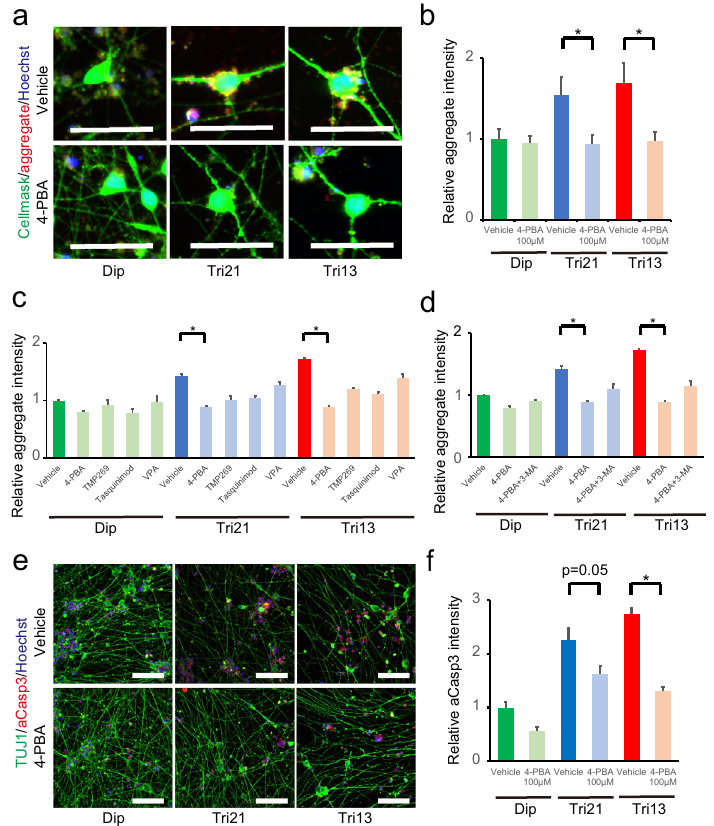
Figure 6. 4-PBA ameliorated aggregation and neuronal loss in trisomic neurons. ( a ) Representative images showing immunocytochemical staining for aggregates (red) in diploid and trisomic NGN2-neurons treated with vehicle or 4-PBA. CellMask (green) and Hoechst 33342 (blue), counterstaining. Scale bar = 50 μm. ( b ) Quantification of relative aggregate intensity per cell in NGN2-neurons on day 14. Data are presented as mean ± SEM normalized to the average of diploid clones. * P < 0.05, n = 5–7 per clone. ( c ) Quantification of relative aggregate intensity per cell in diploid and trisomic NGN2-neurons treated with vehicle or HDAC inhibitors on day 14. Data are presented as the mean ± SEM normalised to the average of diploid clones treated with vehicle. * P < 0.05, n = 3–6 per clone. ( d ) Quantification of relative aggregate intensity per cell in diploid and trisomic NGN2-neurons treated with vehicle, or 4-PBA with or without 3-MA. Data are presented as the mean ± SEM normalised to the average of diploid clones treated with vehicle. * P < 0.05, n = 3–6 per clone. ( e ) Representative images showing immunocytochemical staining of TUJ1 and cleaved caspase 3 in diploid and trisomic NGN2-neurons treated with vehicle or 4-PBA. Scale bar = 200 μm. ( f ) Quantification of relative cleaved caspase 3 intensity in NGN2-neurons treated with vehicle or 4-PBA. Data are presented as mean ± SEM normalized to the average of diploid clones. * P < 0.05, n = 10–13 per clone. 4-PBA, sodium 4-phenylbutyrate; VPA, valproic acid; 3-MA,